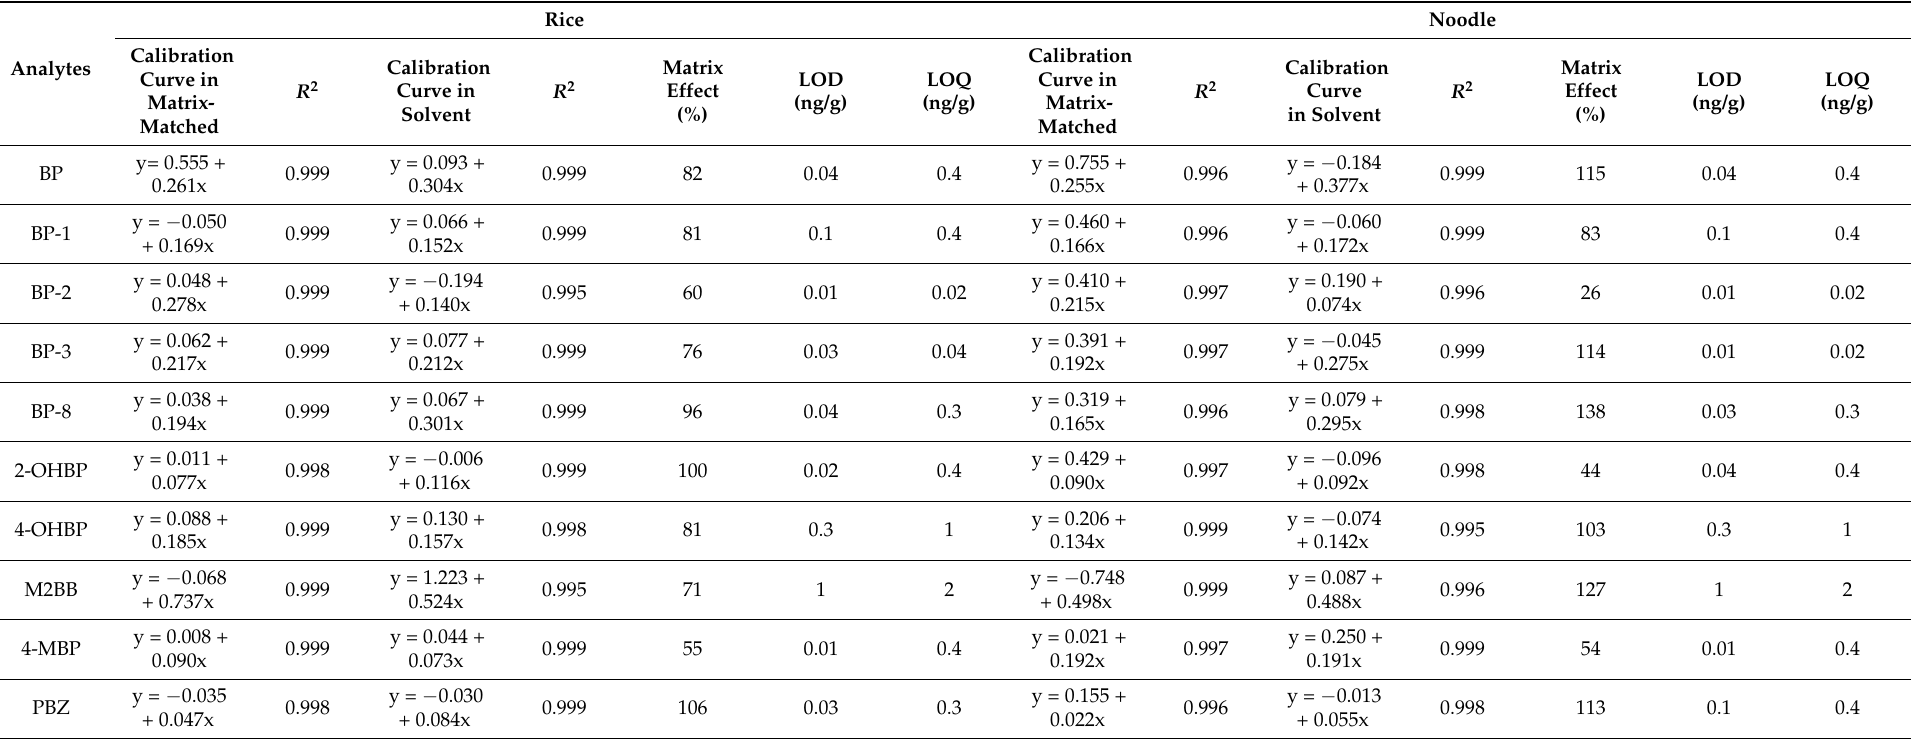
Table 3. Detection characteristics, linear range, matrix effect, limits of detection, and quantitation of target analytes in rice and